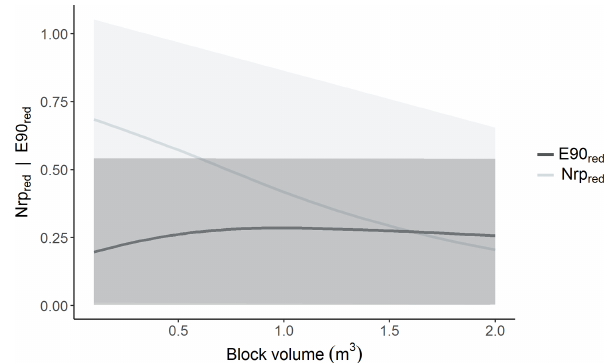
Figure 7. Nrp red (light grey) and E90 red (dark grey) based on the simulation of all forest and terrain scenarios on a concave slope and depending on rock volume using a loess smoothing function and the respective 10 and 90% quantiles